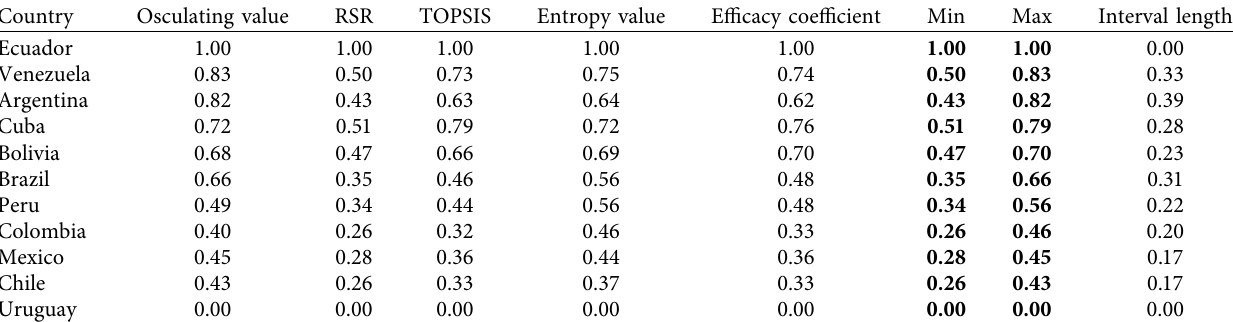
Table 9: Matching result of Chinese power companies in Latin